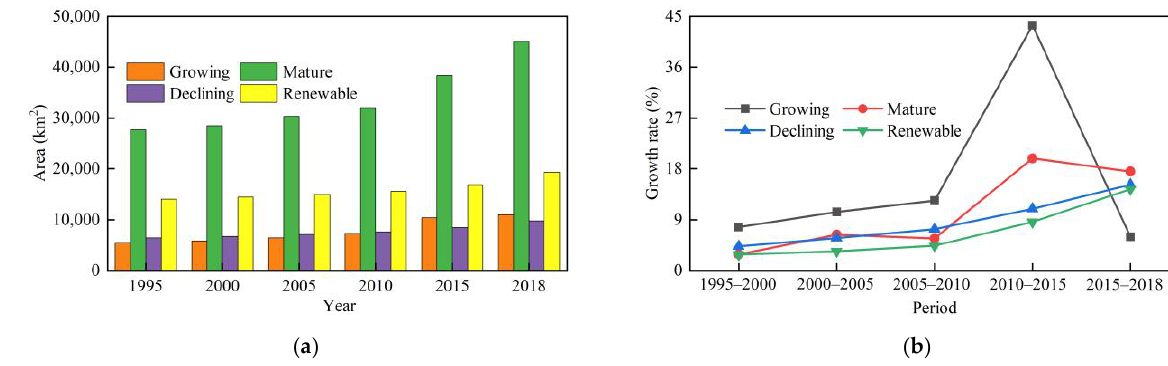
Figure 6. The change of construction land of RBC at various development stages. ( a ) Construction land area; ( b ) growth rate of construction land.